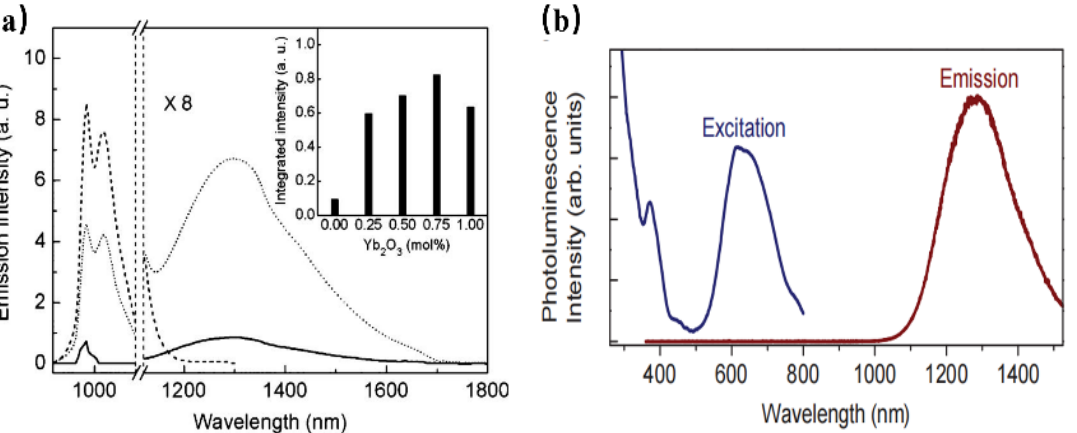
Figure 13. ( a ) Emission spectra of Ni 2+ (solid curve), Yb 3+ (dashed curve), and Yb 3+ /Ni 2+ (dotted curve)-doped LiGa 5 O 8 under 980 nm excitation. The inset shows the dependence of the integrated intensity of Ni 2+ emissions on the Yb 2 O 3 concentration. ( b ) PLE and PL spectra of Zn 3 Ga 2 Ge 2 O 10 :Ni 2+ (Ex = 370 nm and Em = 1290 nm).